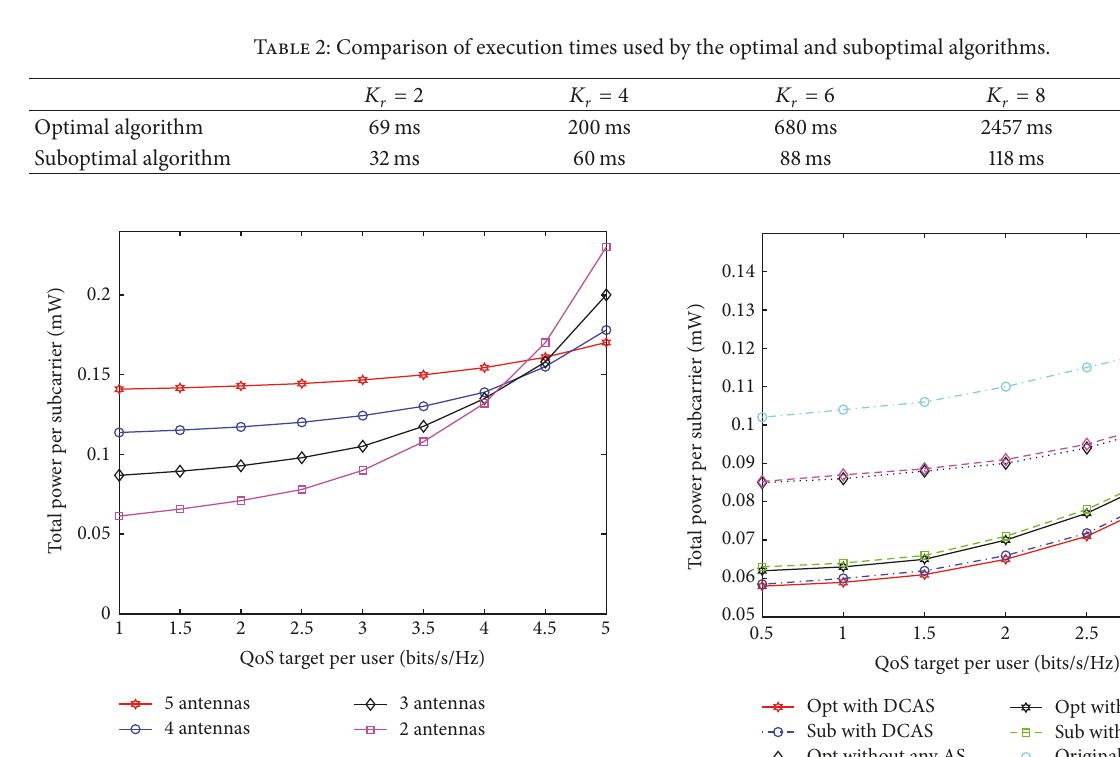
Figure 5: Total power consumption versus QoS target per user. Results are shown for DCAS algorithm when the number of antennas is no less than that of users. Figure 6: Total power consumption versus QoS target per user. Results are shown for different